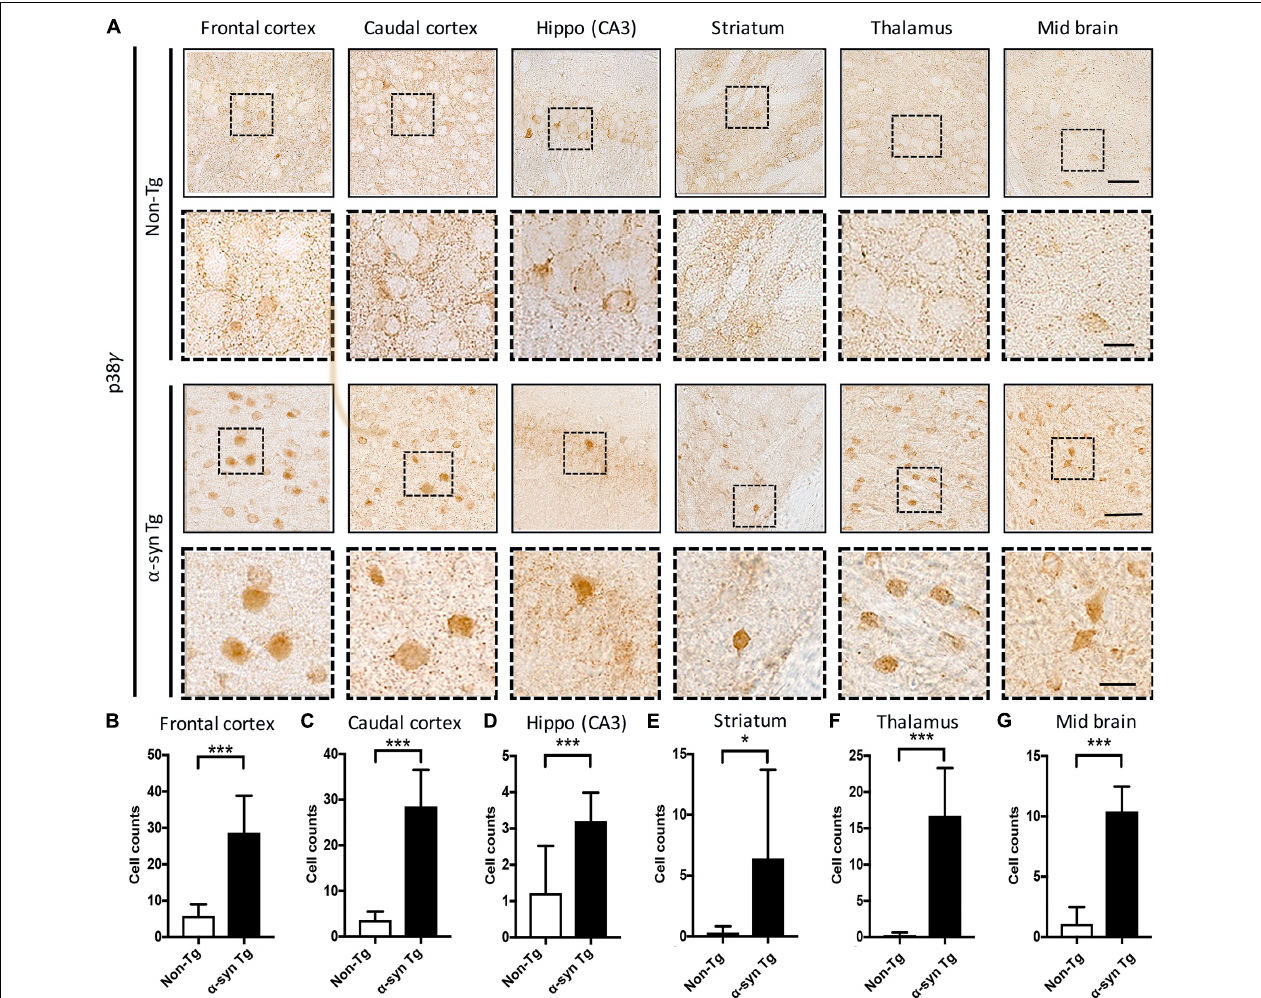
FIGURE 4 | Immunohistochemical analysis of the distribution of p38 γ in brains in non-Tg and α -syn Tg mouse brains. Saggital vibratome sections from complete right hemibrains were immunolabeled with an antibody against p38 γ and developed with DAB. (A) Panels with a solid outline show representative low power bright field microscopic images (200 × ) (scale bar = 100 µ m) of non-Tg (top) and α -syn Tg (bottom) mouse brains immunostained with p38 γ ; panels with a dotted outline show enlarged images (630 × ) (scale bar = 20 µ m) of the indicated region of interest. (B–G) Number of p38 γ -positive cells per 1 mm 2 of the frontal cortex (B) , caudal cortex (C) , hippocampus (D) , striatum (E) , thalamus, (F) and mid brain (G) . n = 6 per group (* p < 0.05, *** p <